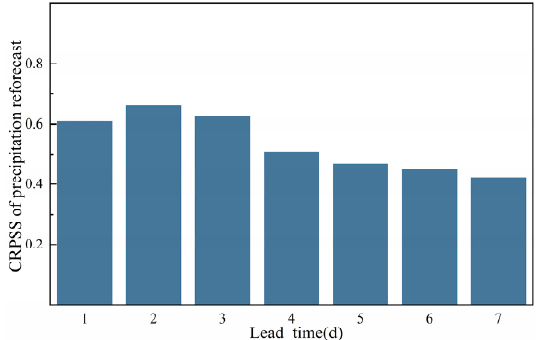
Figure 6. CRPSS (relative to sampled monthly mean climatology) of ECMWF basin–mean precipitation reforecasts at lead times of 1–7 d during the verification period (2007, 2008, June–October). CRPSS = continuous ranked probability skill score.